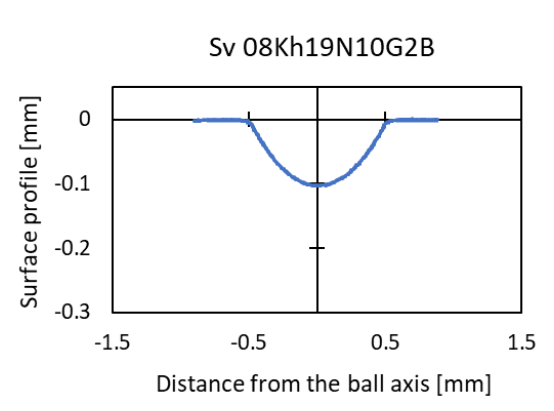
Figure 8. Cross-sectional profile of the spherical indent in Sv 08Kh19N10G2B steel.